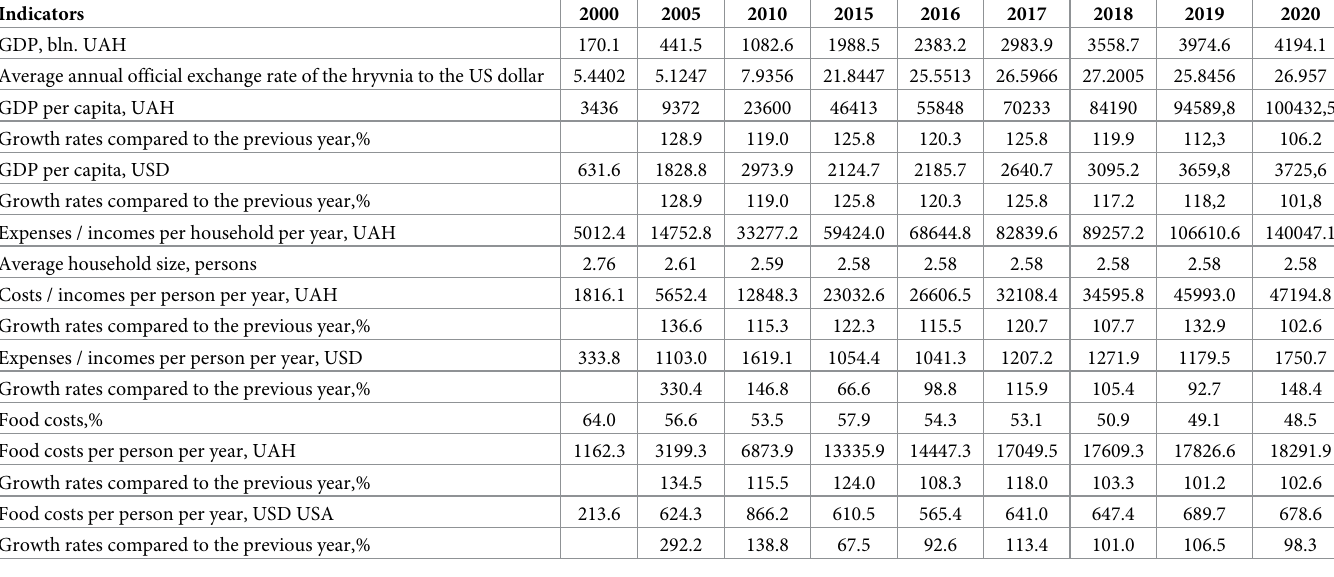
Table 3. Calculation of indicators of the "affordability" category of